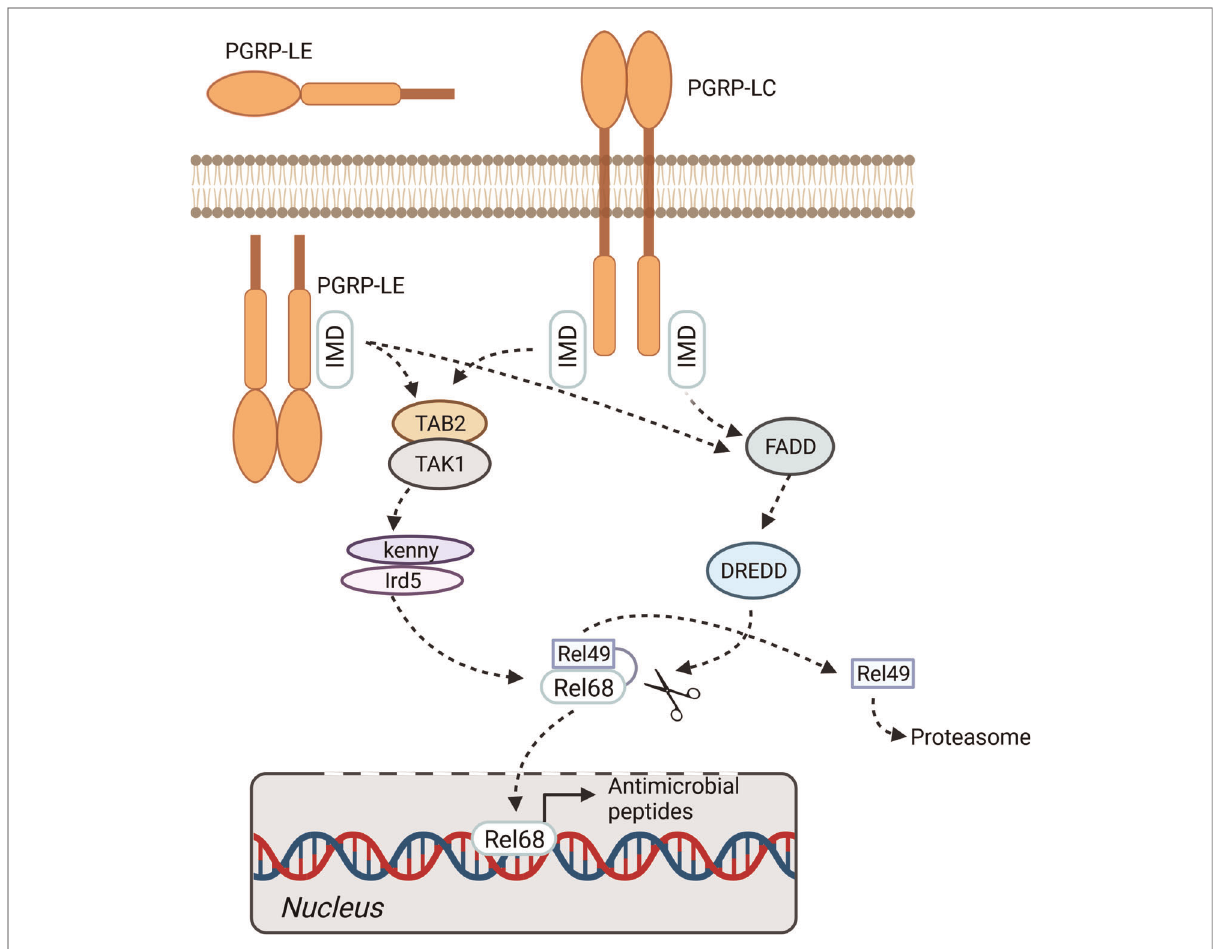
FIGURE 2 IMD pathway. The immune de fi ciency pathway can be activated by membrane bound pattern recognition receptor PGRP-LC or soluble intra- and extracellular receptor PGRP-LE . The activation of the pathway fi nally leads to the phosphorylation and cleavage of the transcription factor relish (Rel68/Rel49). The expression of antimicrobial peptides is activated by translocation of Rel68 into the nucleus. Figure was created with